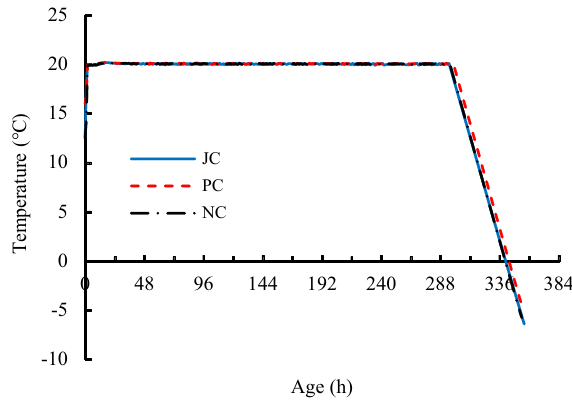
Figure 5: Measured temperature curves of the three concretes under CTC mode.